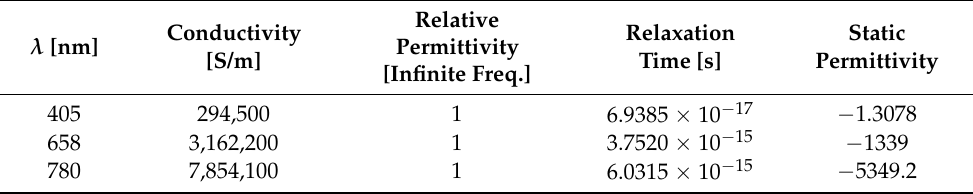
Table 2. Numerical value of the modified-Debye model for Au (Gold).